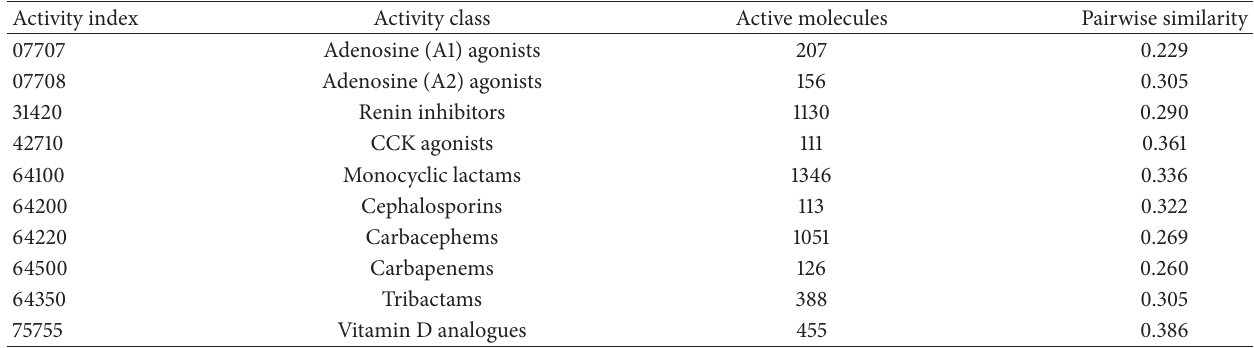
Table 2: MDDR activity classes for DS2 data